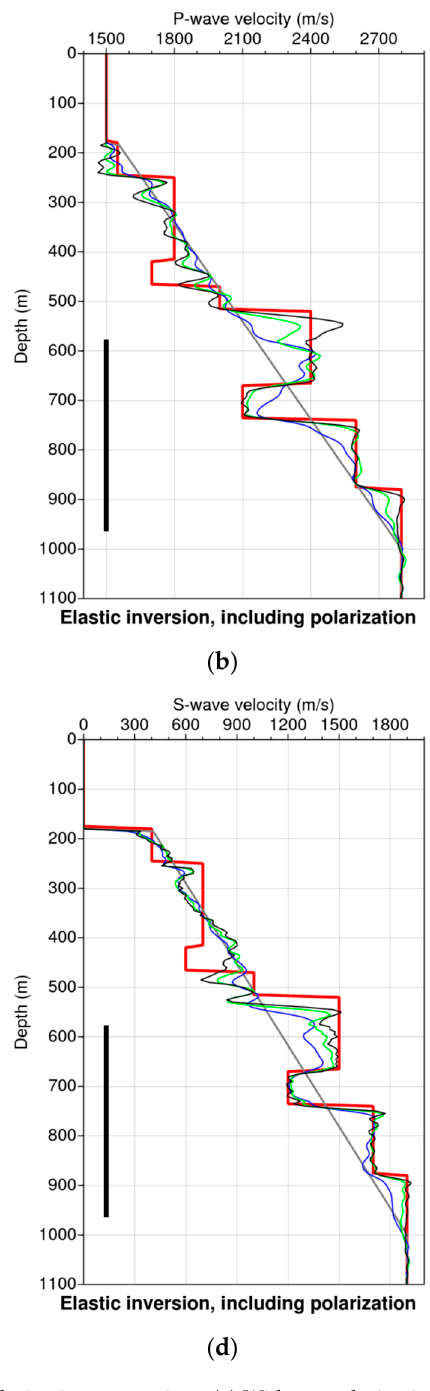
Figure 2. Two inversion experiments with and without polarization constraints. ( a ) Without polarization constraints for P-wave velocity estimated model. ( b ) With polarization constraint for P-wave velocity estimated model. ( c ) Without polarization constraints for S-wave velocity estimated model. ( d ) With polarization constraints for S-wave velocity estimated model. In all plots: red thick solid line denotes the true model we want to retrieve by inverting the observed data; gray solid line denotes the starting model in the inversion process; blue, green, and black solid lines denote estimated models from inversion, respectively, at iterations 10th, 30th, and 80th. The vertical thick black solid line indicates the level of the receiver antenna. The constrained inversion contributes to the recovery of the sharp interfaces, especially at the level of the receiver antenna.